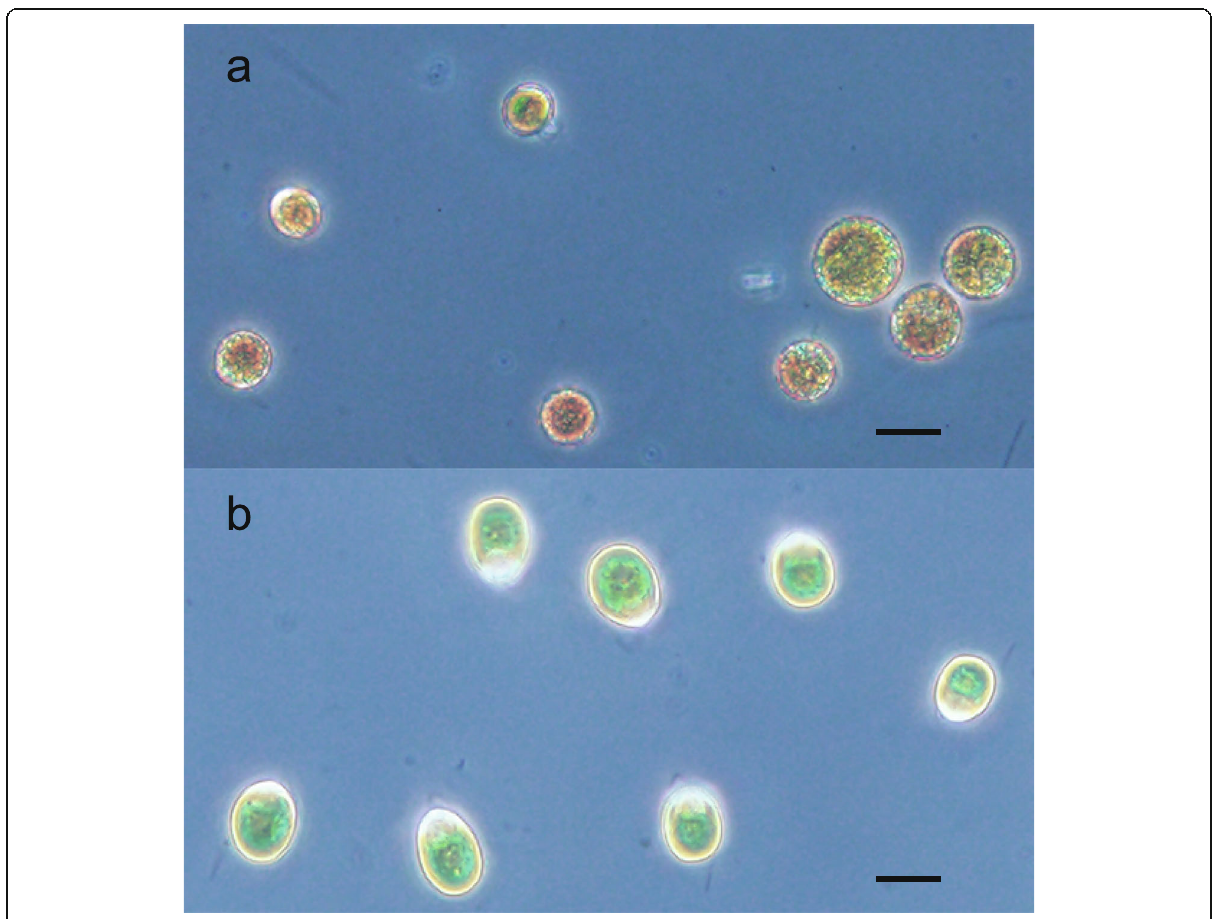
Fig. 1 D. salina cells cultivated under different nutrient conditions. a Cells cultivated in the absence of nitrogen source at 12.5% salinity. b Cells cultivated in the presence of nitrogen source at 17.5% salinity. All scale bars indicate 20 μ